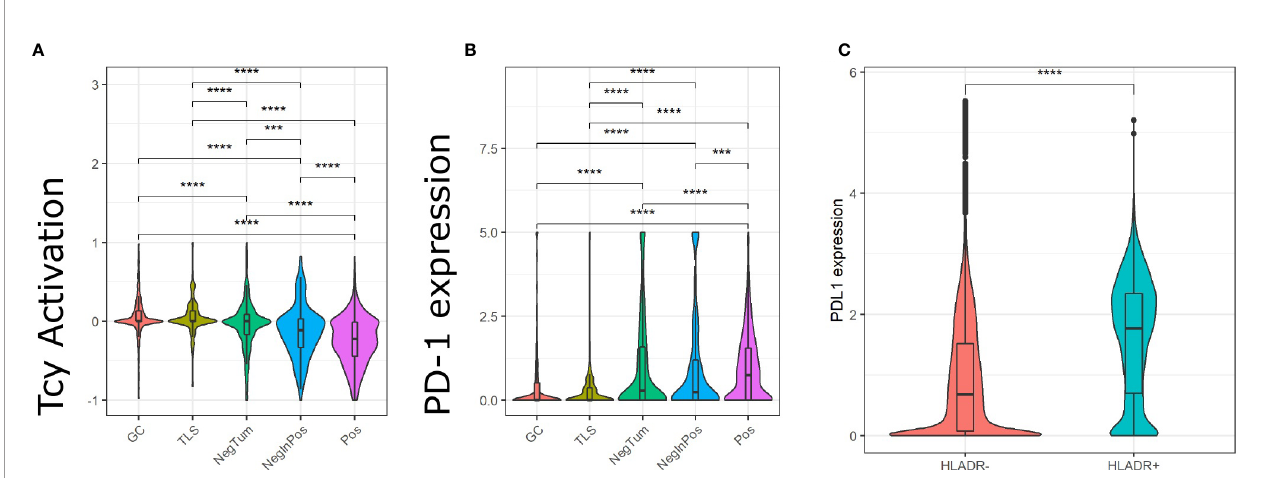
FIGURE 4 | Analysis of Tcy activation status, TIM3 and PD-1 in the in-silico micro dissected areas. Violin plots of the activation score (A) and PD-1 (B) for the cytotoxic T cells (Tcys) in the different micro dissected areas. P-values are derived from pairwise t-test (A) and Wilcoxon test (B) . (C) Difference in expression of PD-